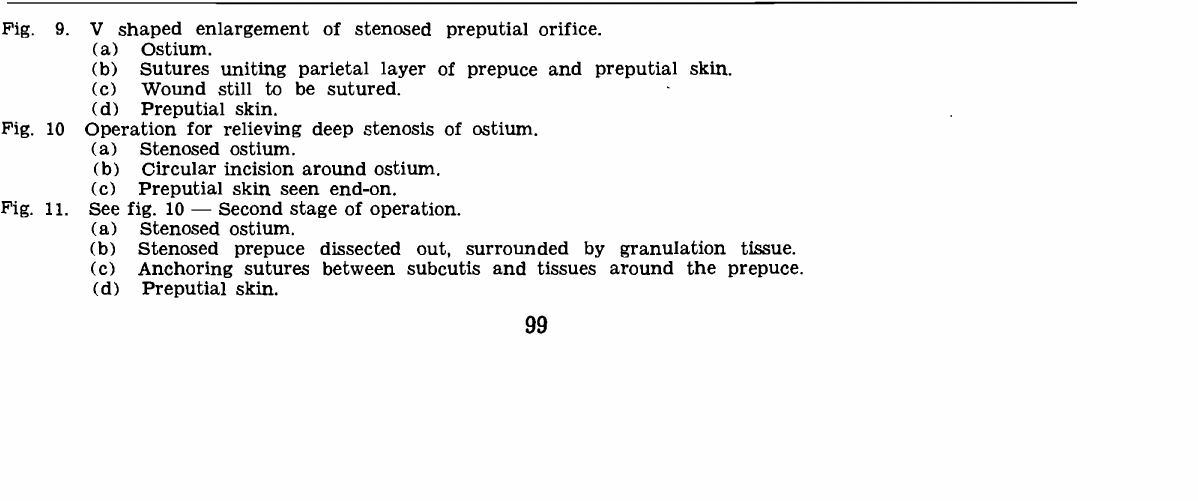
Fig. 9. V shaped enlargement of stenosed preputial orifice. (al Ostium. (bl sutures uniting parietal layer of prepuce and preputial skin. (cl Wound still to be sutured. (dl Preputial skin. Fig. 10 Operation for relieving deep stenosis of ostium. (al Stenosed ostium. (bl Circular incision around ostium. (cl Preputial skin seen end-on. Fig. 11. See fig. 10 - Second stage of operation. (al Stenosed ostium. (bl Stenosed prepuce dissected out, surrounded by granulation tissue. (cl Anchoring sutures between SUbcutis and tissues around the prepuce. (dl Preputial